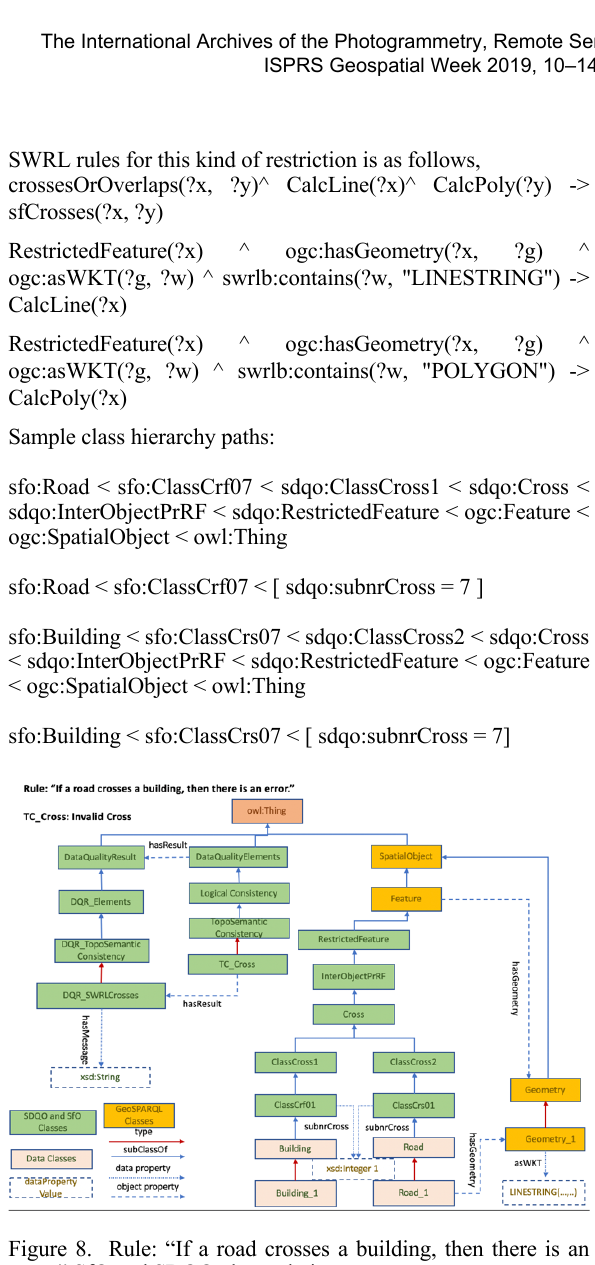
Figure 8. Rule: “If a road crosses a building, then there is an error.” SfO and SDQO class